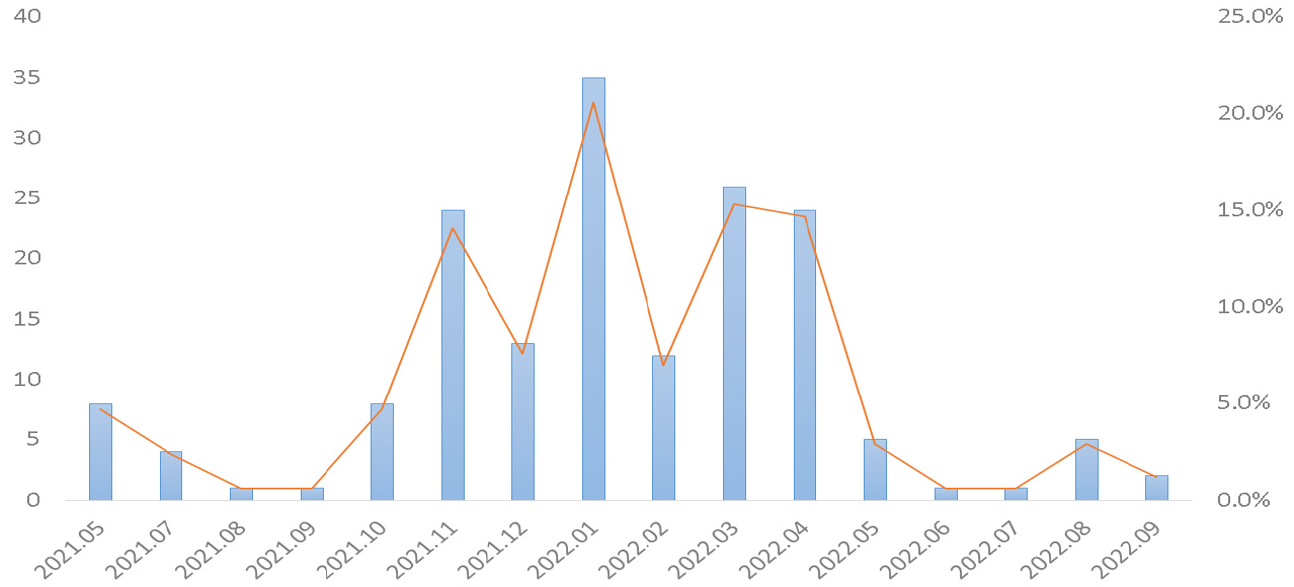
Figure 1. Prevalence of respiratory organisms detected by FilmArray TM RP assay.